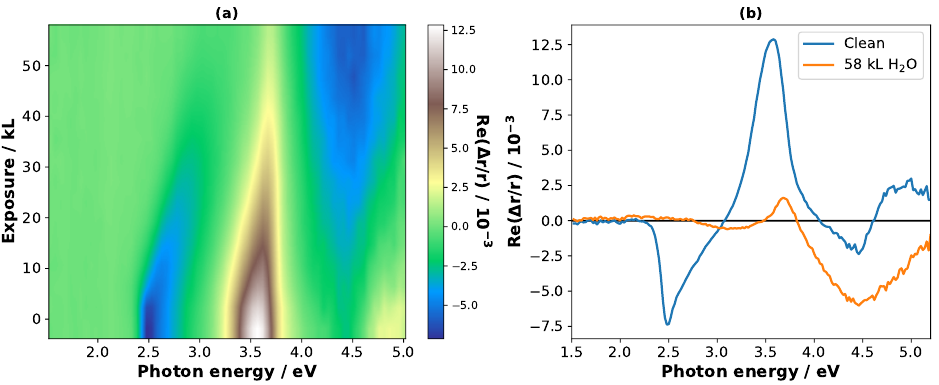
Figure 2: Water exposure of P-rich GaP(100). (a) Colourplot showing the time- evolution of the RA spectrum during exposure. (b) Spectra before (blue) and after (orange)